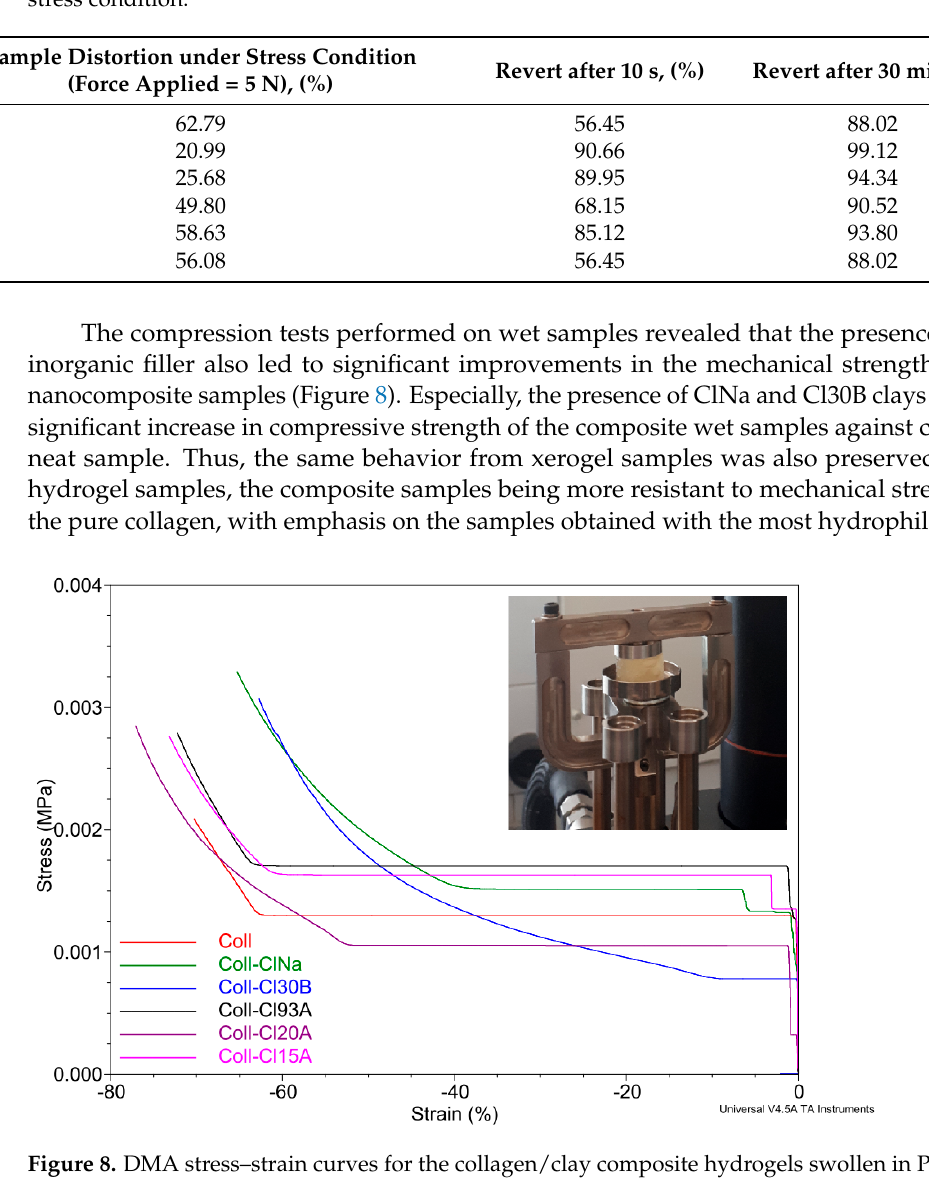
Table 2. Behavior of dried samples under stress applied. Revert to the initial form after stress condition.